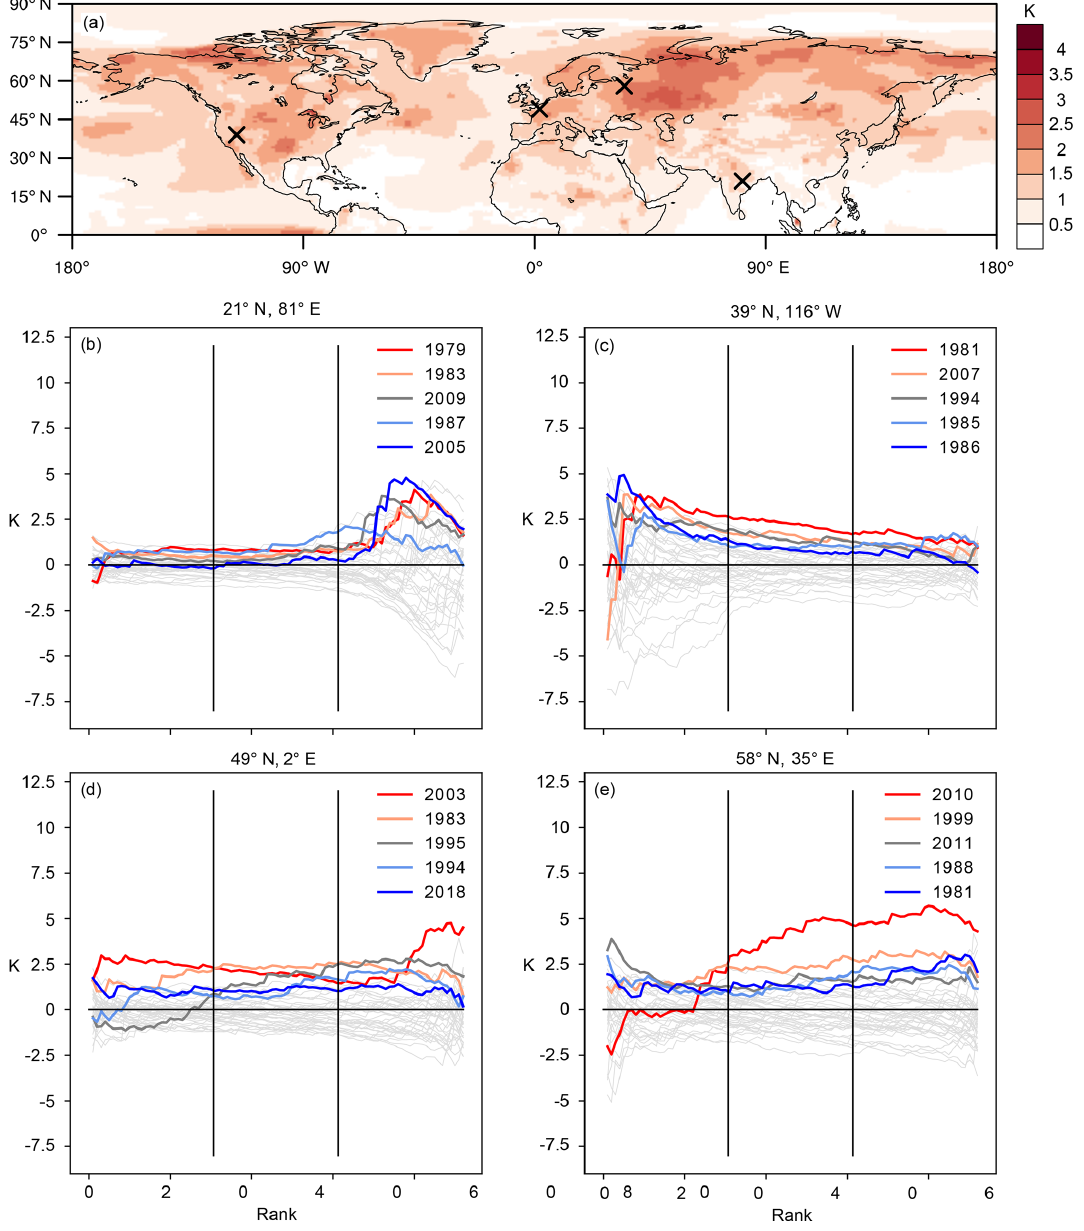
Figure 3. Extreme-summer T2m anomaly and extreme-summer substructure for selected grid points in ERA-Interim. Panel (a) depicts XA ERAI ; panels (b) – (e) show RDA ERAI for the five ERA-Interim extreme summers in colours and for the remaining summers in light grey. d,k Crosses in panel (a) indicate the grid points for which the RDA ERAI values are shown in panels (b) – (e) d,k